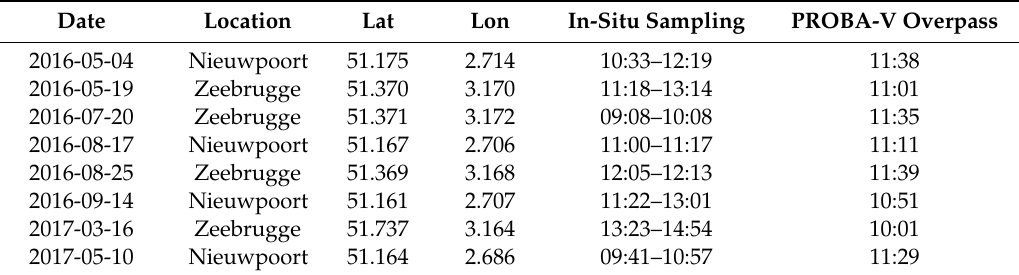
Table 2. Summary of the collected in-situ turbidity data. Date, location, latitude ( ◦ N), longitude ( ◦ E) and in-situ sampling time are given, together with the overpass time of PROBA-V times are expressing in local